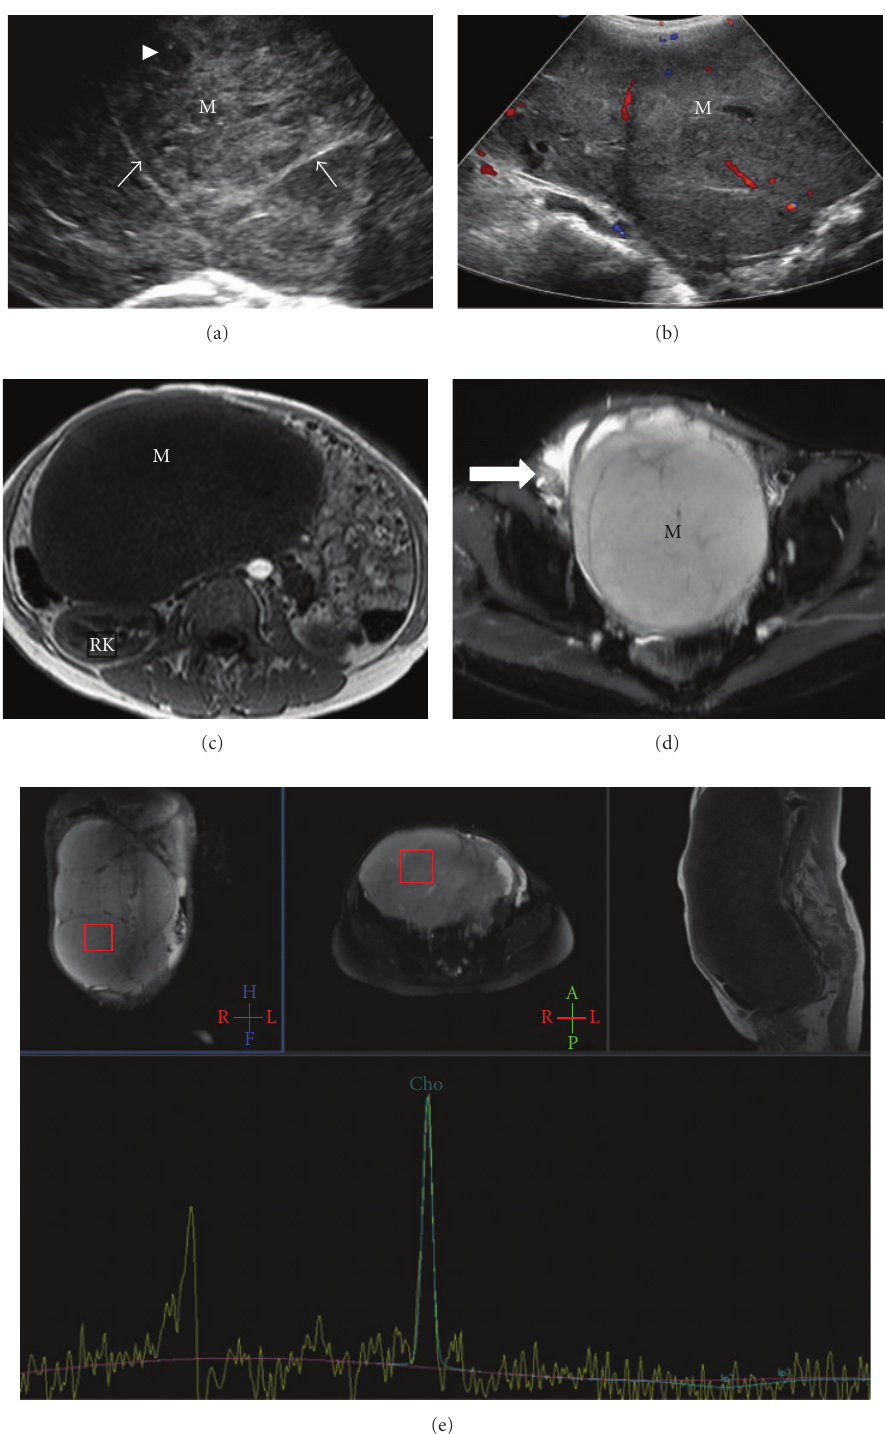
Figure 1: (a) Transabdominal ultrasound showing a heterogeneously hypoechoic mass (M) with internal septations (white arrows) and central necrosis (arrowhead). (b) Color and spectral Doppler images showing few internal vascular channels with arterial flow. (c) T1W axial image of the abdomen. The tumor is hypointense causing mass e ff ect on to the adjacent structures. The right kidney is pushed more pos- teriorly. (d) T2W axial image showing the tubular gonadal structure in the region of right inguinal canal. (e) MR spectroscopy showing a high choline peak compatible with a tumor